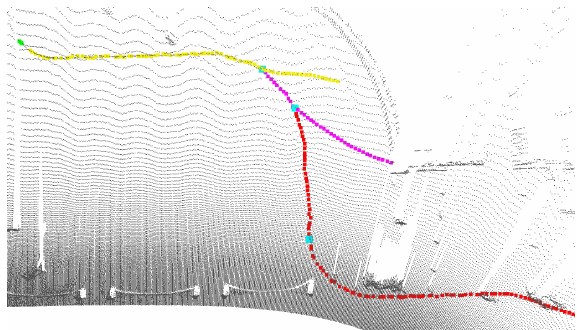
Figure 9: Result of the prediction/estimation road side detection model with two interactions. The yellow curve is the initial result, the purple curve is the result with one interaction and the red one is obtained using two interactions. The cyan points correspond to user mouse clicks. The second cyan point has been clicked two times: as second click for the first redirection and as first one for the second redirection.